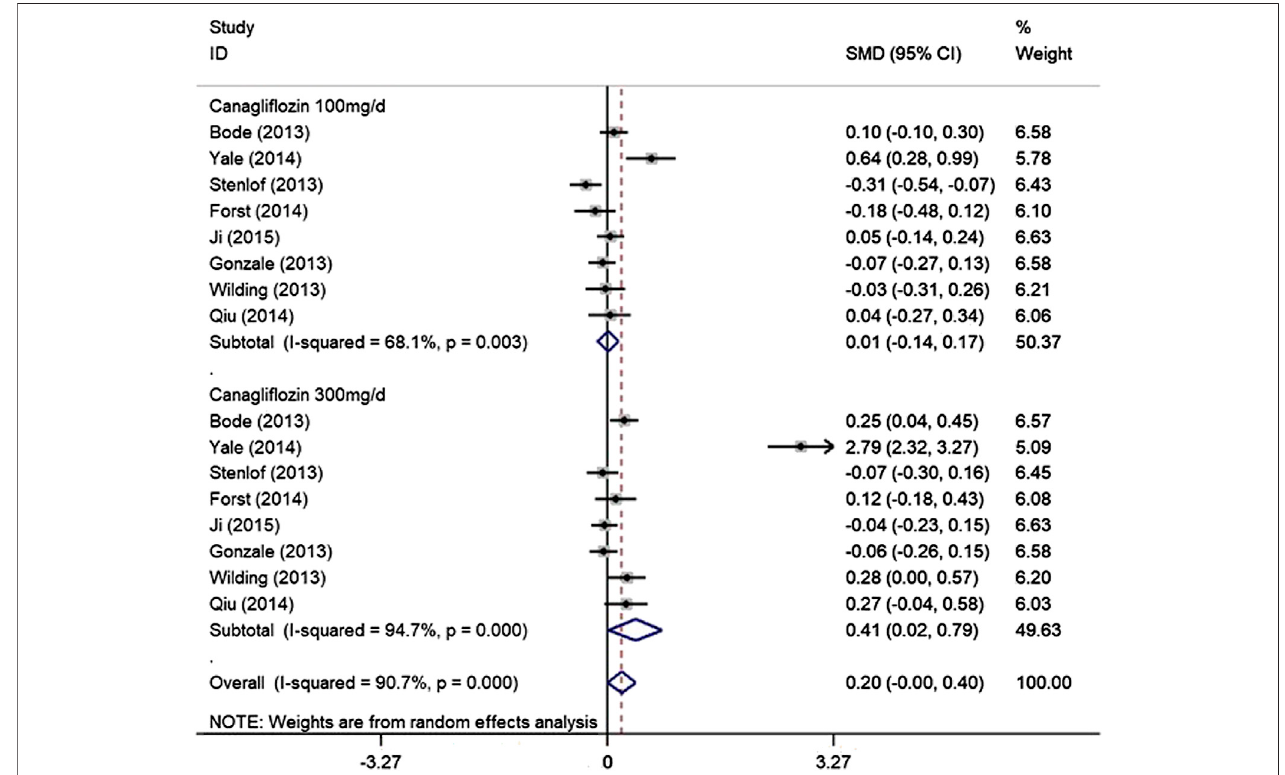
FIGURE 6 | Forest plot detailing subgroup analysis of the effect of canagli fl ozin on the Creatinine of the T2DM participants based on dosage.